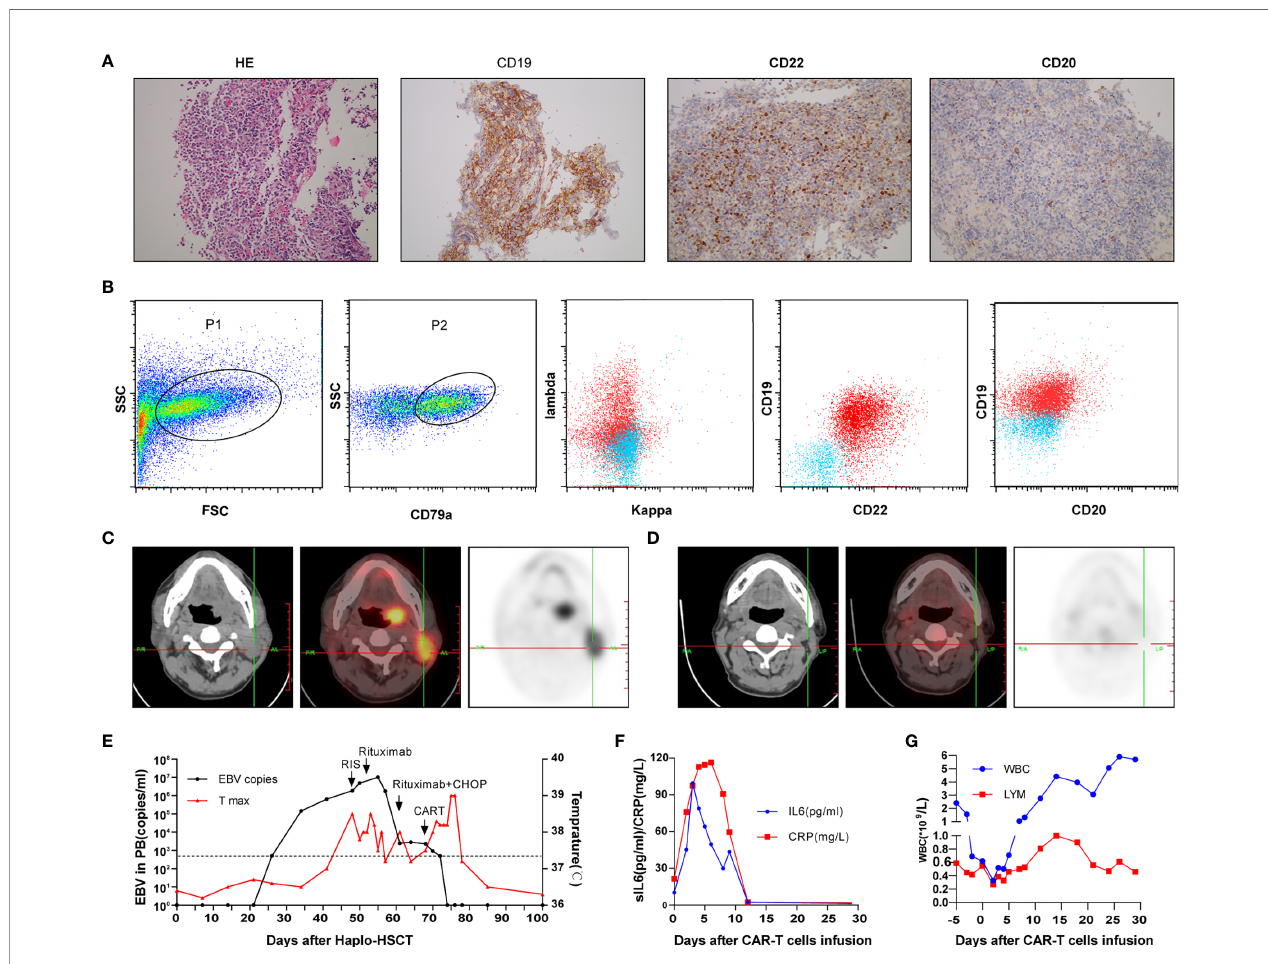
FIGURE 1 | Cervical lymph node biopsy (A) and immunophenotypic analysis (B) of case 1 by fl ow cytometry revealed a CD20-negative EBV-PTLD; Computed tomography and positron emission tomography images before (C) and after treatment (D) ; Timeline of EBV PCR and clinical data (E) ; CRP, sIL6 (F) and peripheral hemogram (G) after CAR-T